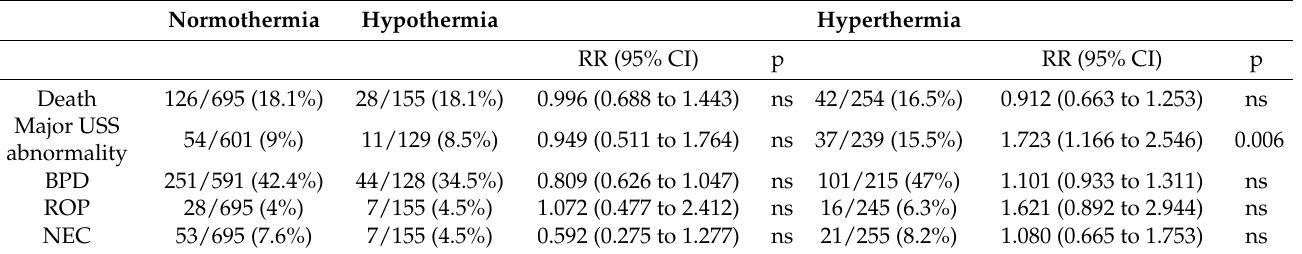
Table 2. Clinical outcomes by temperature group.